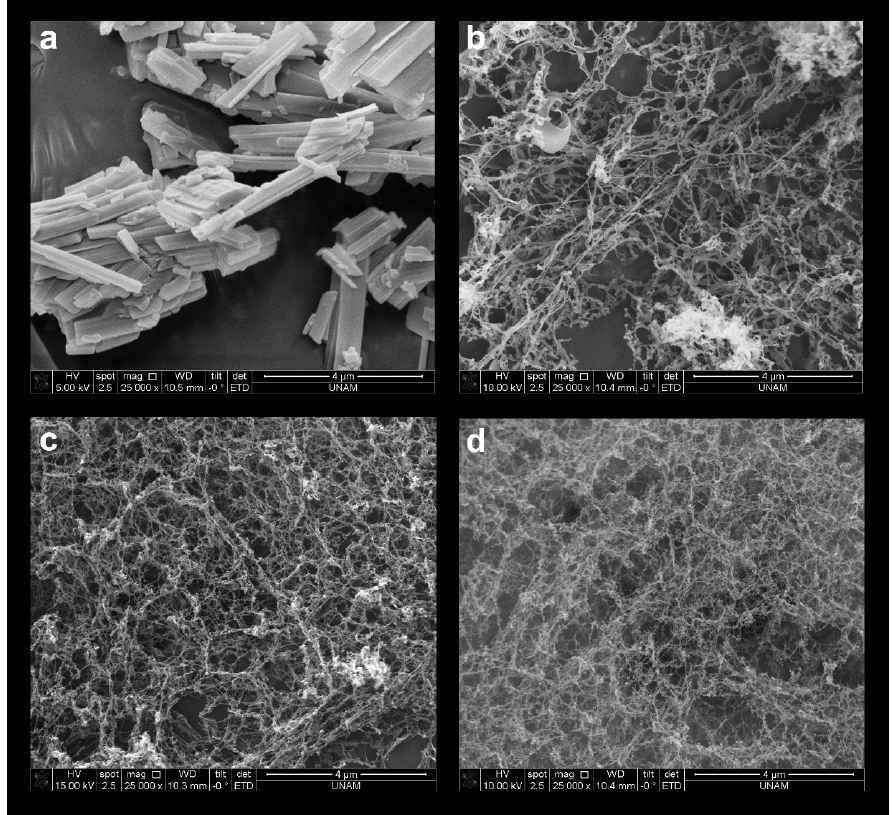
Figure 2. SEM images of ( a ) free PCX, ( b ) PCX:Hp β CD, ( c ) PCX:M β CD and ( d ) PCX:Hp γ CD inclusion complexes.